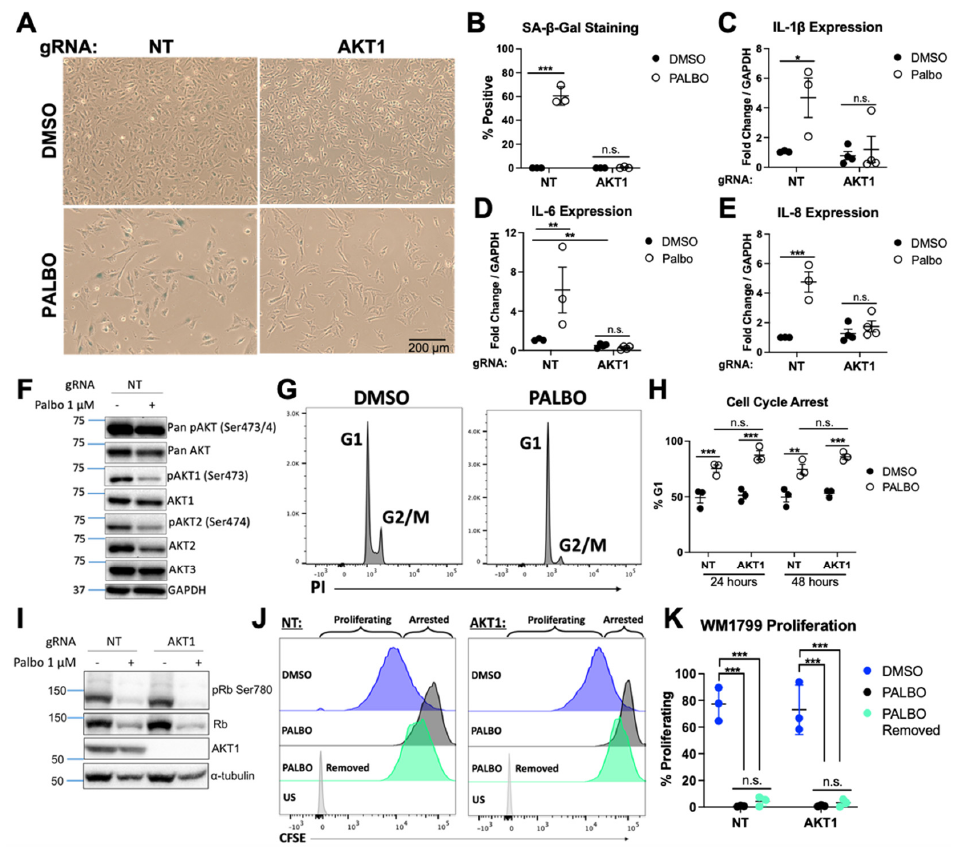
Figure 2 . AKT1 knockout clones exhibit impaired senescence and SASP production ( A ).